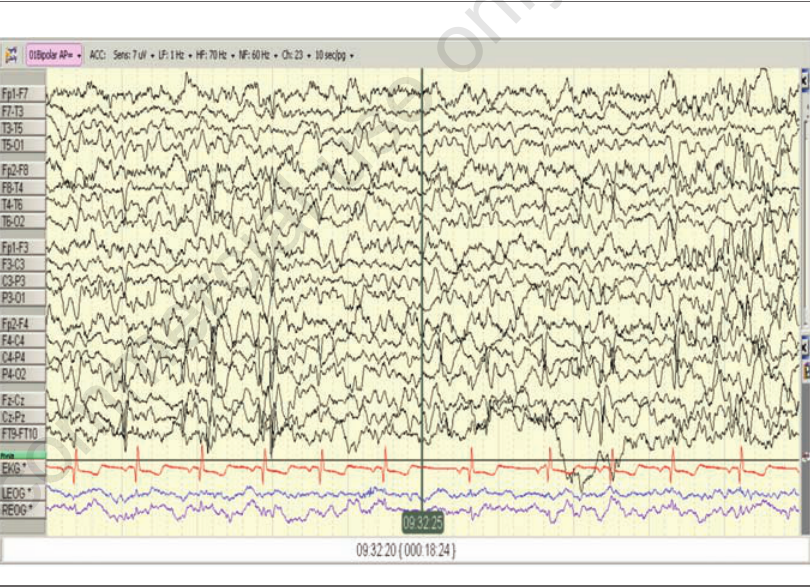
Figure 1. Example of infrequent generalized spike and wave discharges.